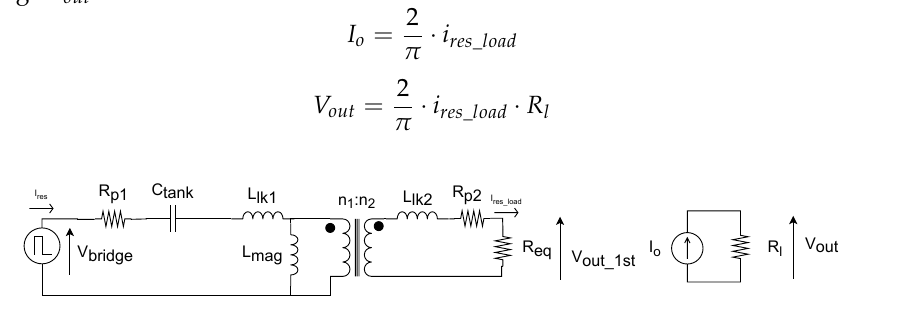
Figure 6. Network for first harmonic analysis.